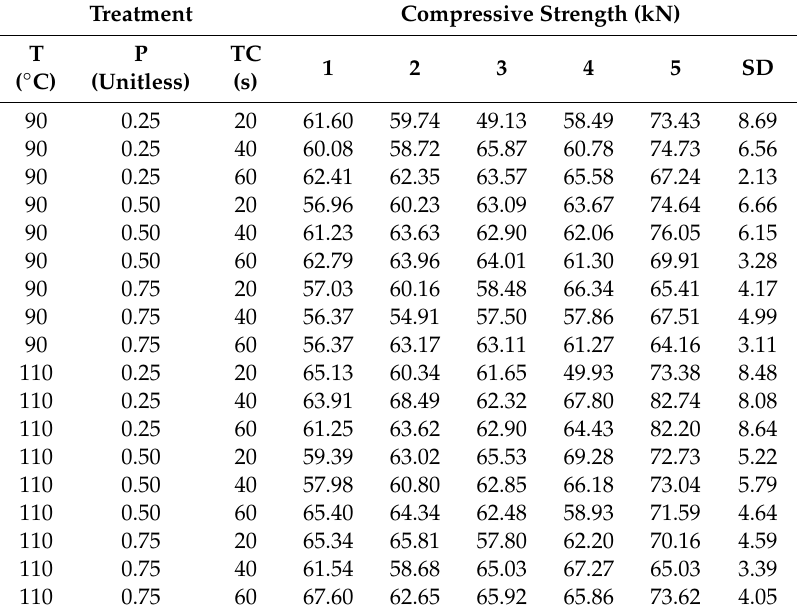
Table 8. Results for compressive strength in rice husk and pine sawdust briquettes. Treatment Compressive Strength